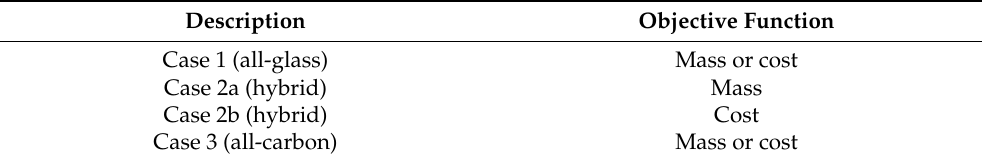
Figure 3. Thickness distribution of the reference all-glass spars: ( a ) continuous and ( b ) discretized representations. Table 3. Spar optimization